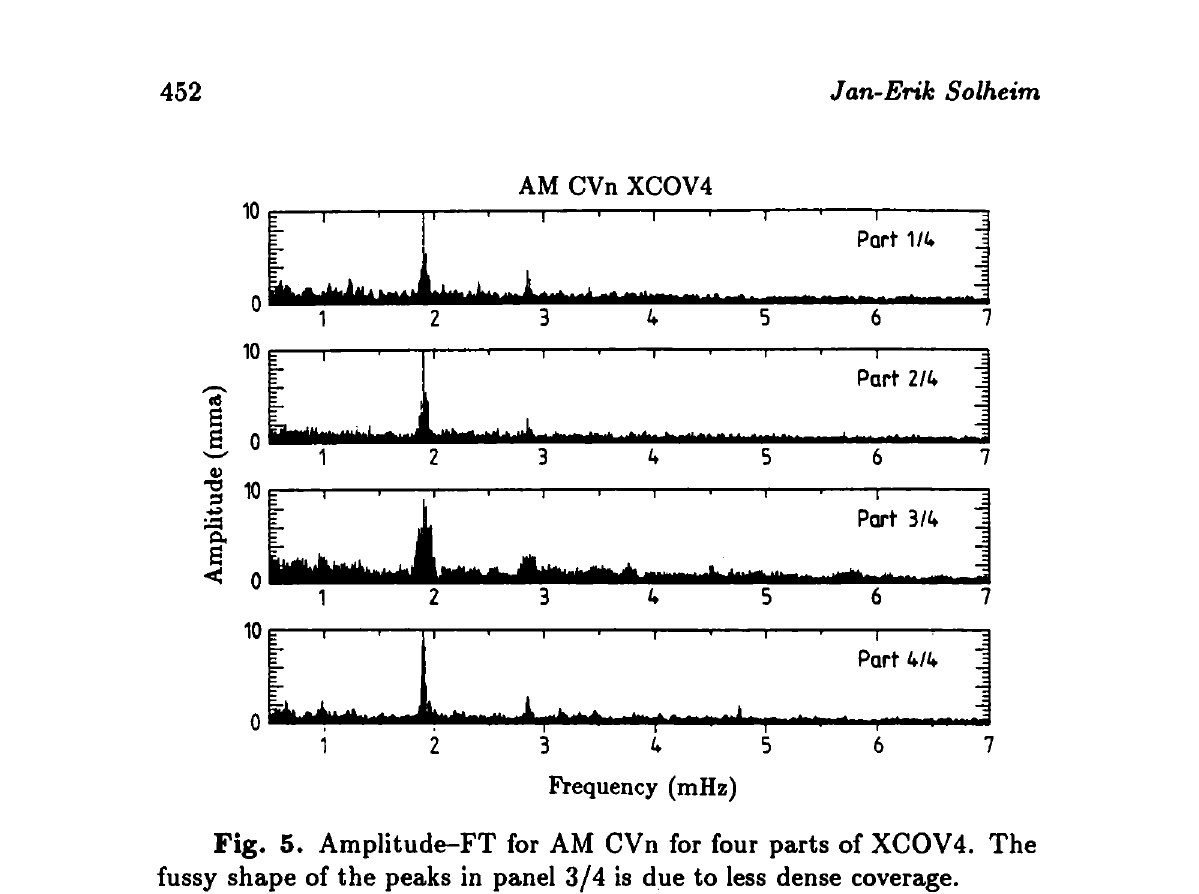
Fig. 5. Amplitude-FT for AM CVn for four parts of XCOV4. The fussy shape of the peaks in panel 3/4 is due to less dense